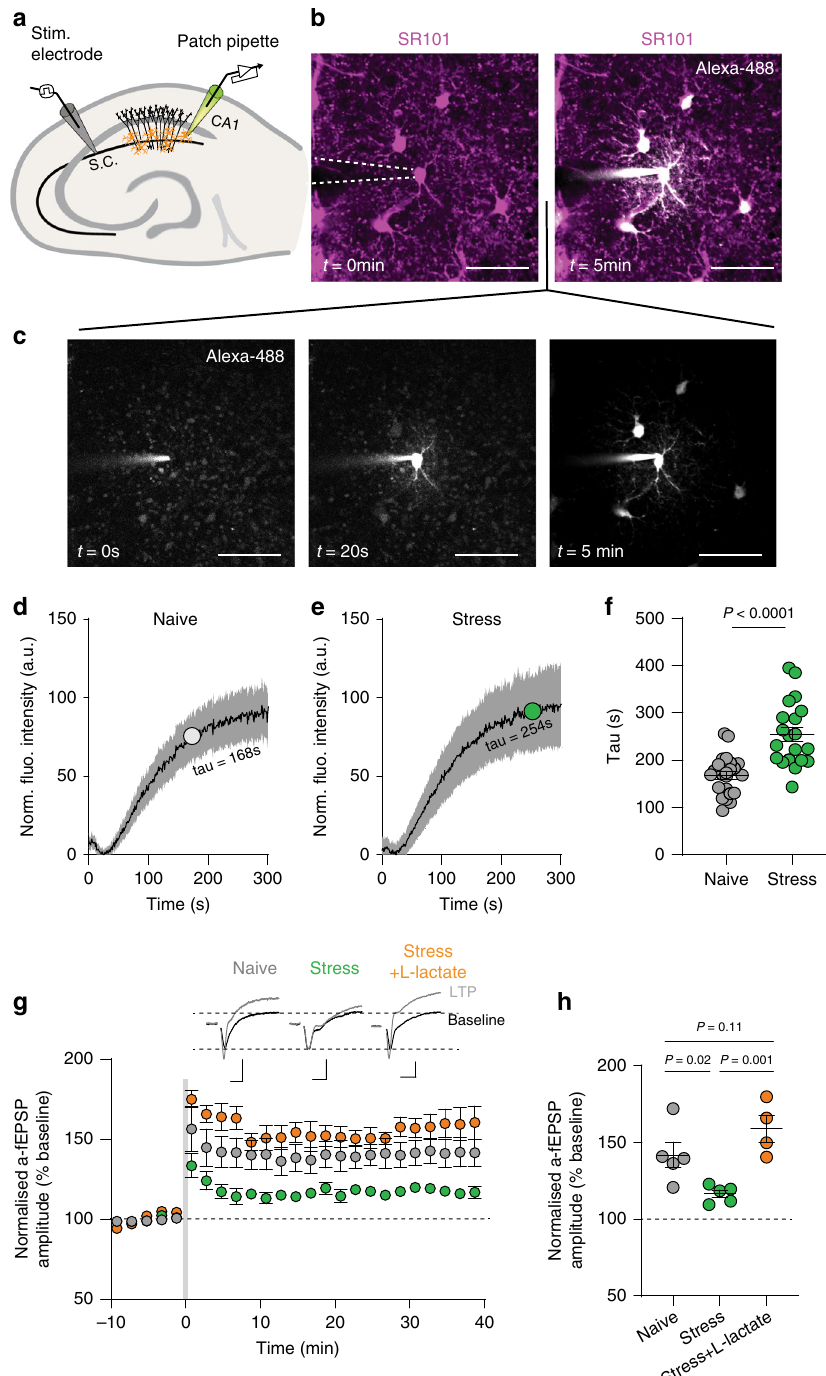
Fig. 7 L -lactate delivery through astrocytes rescues stress-induced impairment of LTP in the hippocampus. a Schematic representation of subsequent patch-clamp experiments in CA1 region of ventral hippocampus (s.c. denotes schaffer collateral). b Representative images depicting a dye fl ux through astrocyte network in ventral hippocampal slices, before patching (left) and 5 min after whole-cell patch (right). Scale bar 50 µ m. c Series of images from b depicting progression of dye fl ux through gap junction connected astrocytes at 0 s, 20 s, and 5 min. d Mean trace of coupling in naïve group with tau value indicated. Error indicates standard deviation. n = 23 cells . e Mean trace of coupling in stress group with tau value indicated. Error indicates standard deviation. n = 20 cells. f Scatter dot plot quantifying coupling between hippocampal astrocytes in naïve and stress conditions. Naïve: n = 23 cells, stress: n = 20 cells. Error bars: mean ± s.e.m. g Time series comparing hippocampal LTP in naïve, stress, and stress + L -lactate conditions, measured through astrocyte-patch technique. High-frequency stimulation (HFS) indicated by gray bar. Naïve: n = 3 mice, n = 5 cells; Stress: n = 3 mice, n = 5 cells; Stress + L -lactate: n = 3 mice, n = 4 cells. Error bars: mean ± s.e.m. Inset, representative a-fEPSP traces pre- and post-LTP induction. Scale bars: 0.5 mV,10 ms. h Scatter dot plot comparing amplitude of potentiation at 30 – 40 min post HFS from g . Error bars: mean ± s.e.m. One-way ANOVA, F = 9.46, P =